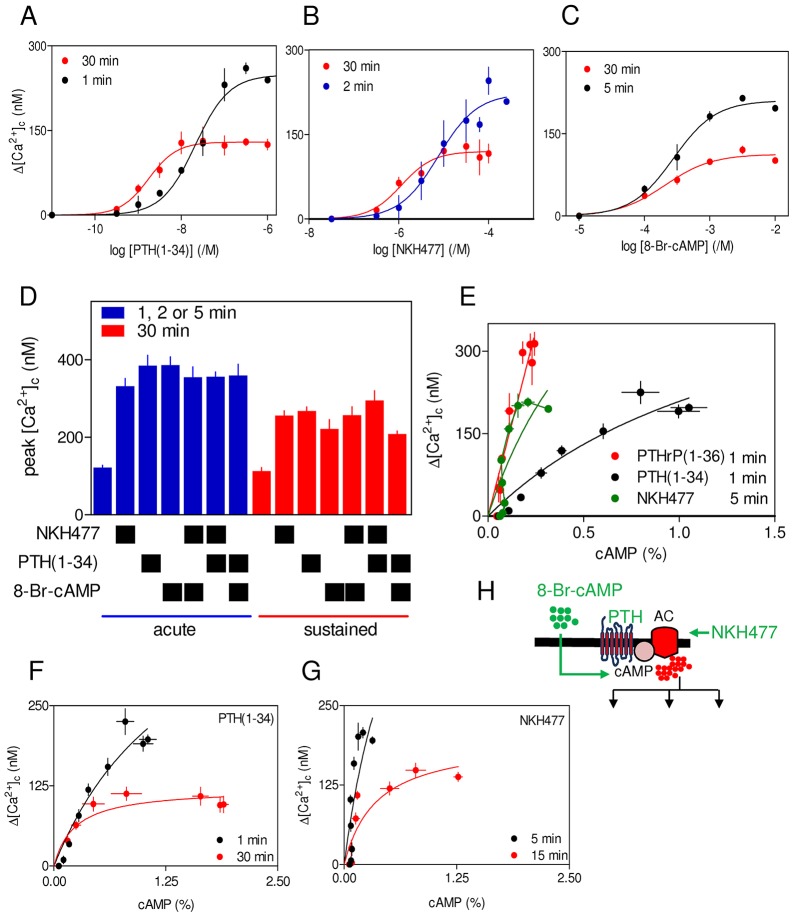
Diminished potentiation of carbachol-evoked Ca2+ signals after sustained increases in intracellular cAMP concentration. (A–C) Peak increases in [Ca2+]c evoked by addition of carbachol (20 µM) in Ca2+-free HBS to cells preincubated with PTH(1-34) (A), NKH477 (B) or 8-Br-cAMP (C) for the indicated times. Δ[Ca2+]c denotes the difference in the peak increase in [Ca2+]c evoked by carbachol alone and after each pretreatment. (D) Similar experiments to those in A–C, show the effects of carbachol (20 µM) on the peak increase in [Ca2+]c after the indicated combinations of treatments for 1 min [PTH(1-34)], 2 min (NKH477) or 5 min (8-Br-cAMP) (denoted acute) and 30 min (denoted sustained). (E) Comparison of the relationship between cAMP and Δ[Ca2+]c for cells acutely stimulated with PTH(1-34) (1 min, n = 7), PTHrP(1-36) (1 min, n = 3) or NKH477 (5 min, n = 8). (F,G) Relationships between cAMP and Δ[Ca2+]c for cells stimulated with carbachol (20 µM) after acute or sustained stimulation with PTH(1-34) (F) or NKH477 (G). Results are means±s.e.m. for n = 4 (A–D) or at least n = 3 (F,G). (H) Targets of the drugs used. AC, adenylyl cyclase.